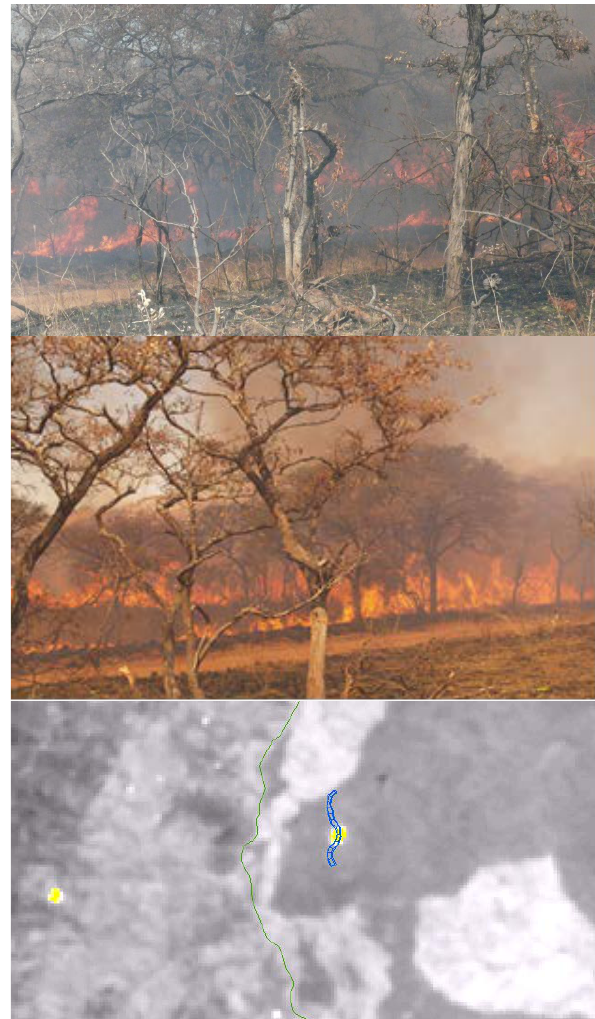
Figure 11 upper: photographs of fire at Shabeni plot No. 3 shortly after TET-1 overpass, Lower: TET-1 satellite image (FRP of fire detections in yellow, background: mid wave -IR channel, National Park boundary in green, plot outlines of Shabeni plot string in blue (origin from Govender,